Question: Summarize what this figure shows in one sentence.
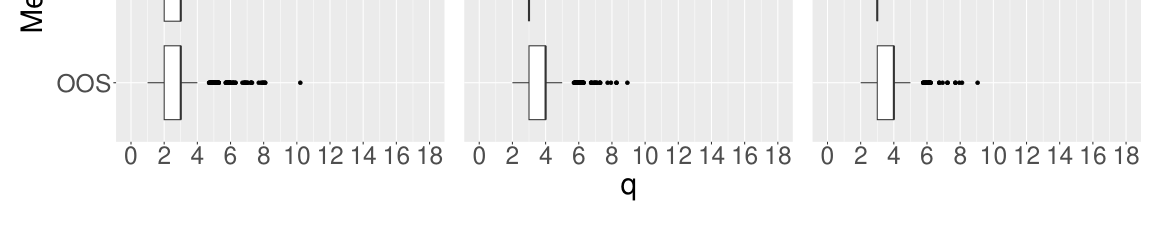
Answer: Simulation 2: boxplots for q (the number of hidden nodes selected) for the models selected by each objective function.